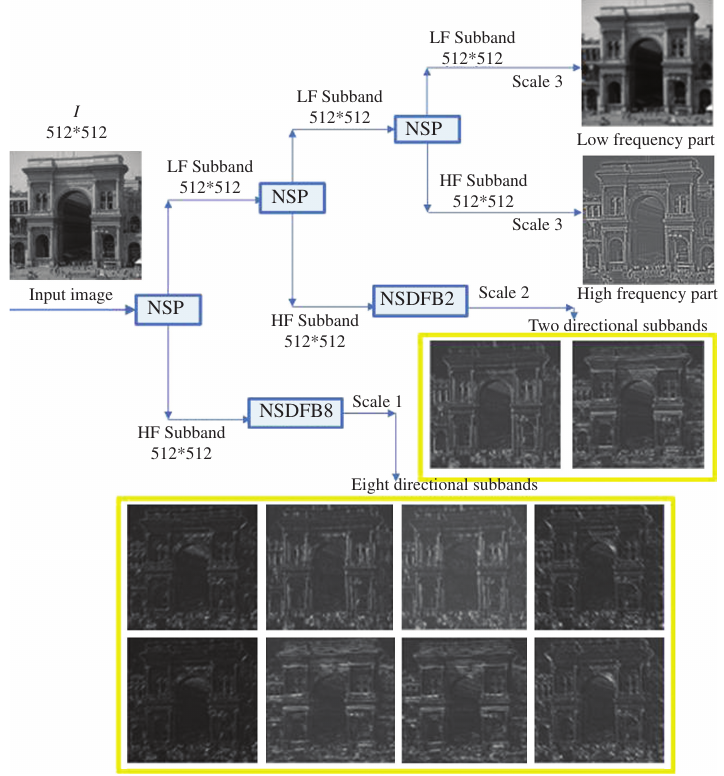
Figure 4. An Example of the NSCT Decomposition on a 512 × 512